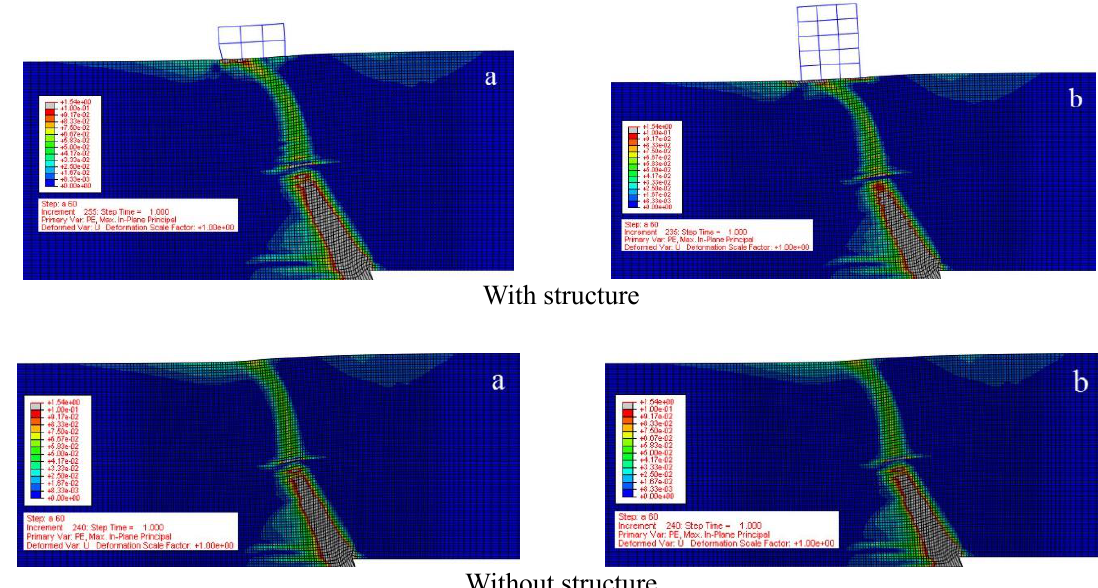
Fig. 17. Fault route in two soil layers with LS-DS density: (a) 2 floors and (b) 5